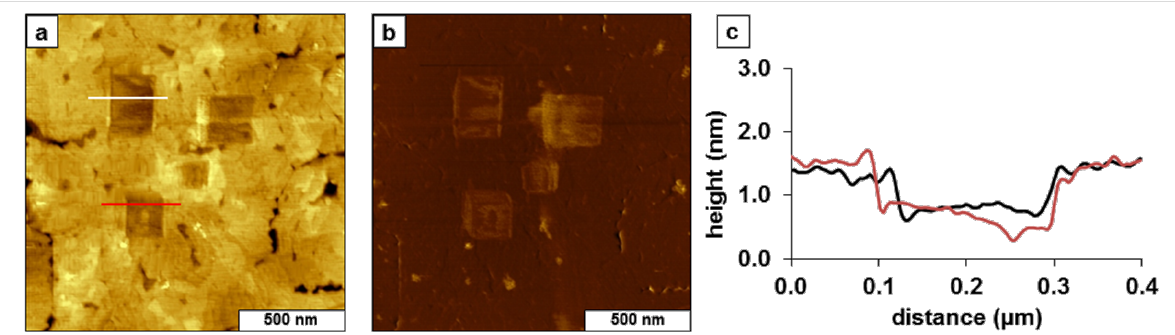
Figure 7: Nanografted patterns of TMMH within a dodecanethiol SAM. (a) Topograph of squares of TMMH (1.5 × 1.5 µm 2 ); (b) lateral force image for (a); (c) height profile across two TMMH nanopatterns in (a ) .